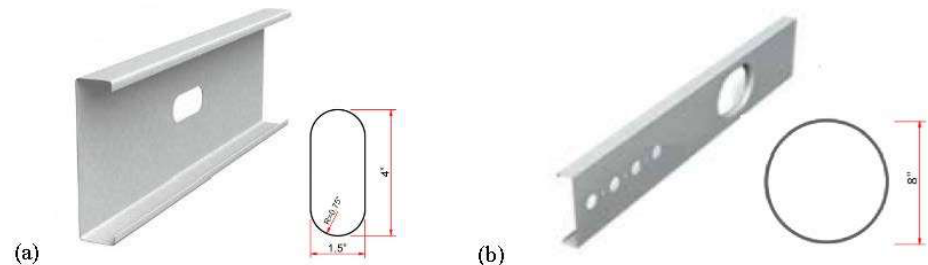
Figure 2. Cold-formed steel joists used in Parnell et al. [35]: ( a ) Dietrich C-stud joists (CSW); ( b ) Dietrich TradeReady joists (TDW). The figures are reproduced from the company website (www.clarkdietrich.com (accessed on 1 January 2022)).